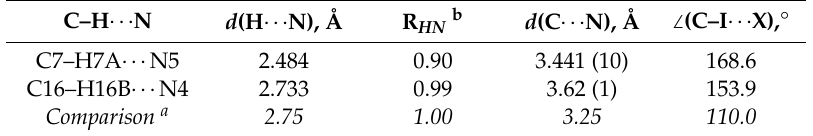
Figure 6. The C–H ··· N HBs in ASZ · 1.5( 1,4-FIB ). Figure 6. The C–H···N HBs in ASZ ·1.5( 1,4-FIB ). Table 3. Parameters of the C–H ··· N HBs in ASZ · 1.5( 1,4-FIB Table 3. Parameters of the C–H···N HBs in ASZ ·1.5( 1,4-FIB ).